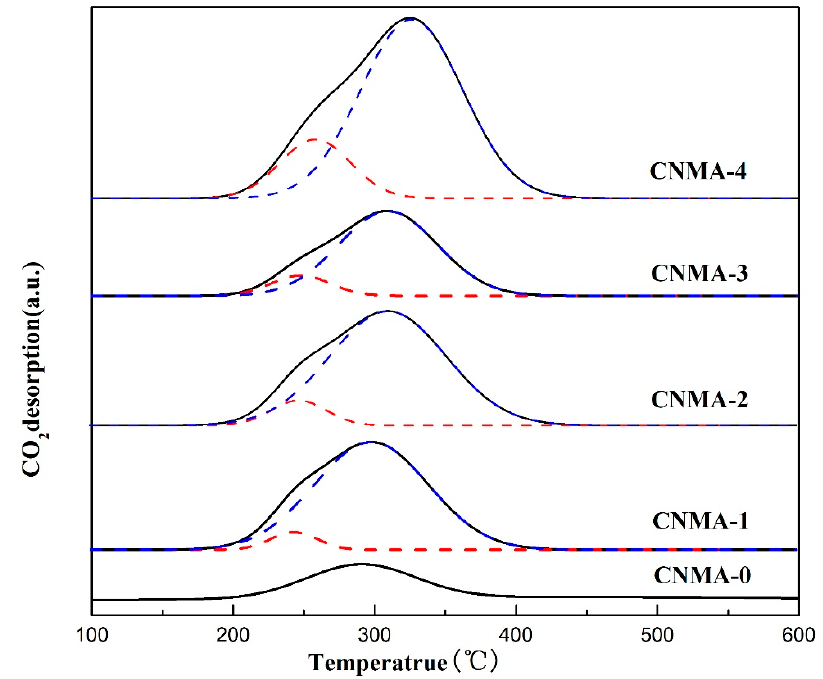
Figure 7. CO2 temperature desorption spectroscopy (CO 2 -TPD) profiles of the reduced samples with different Ni amounts, the TPD, α and β peaks are shown as solid, dash and dot lines, respectively.